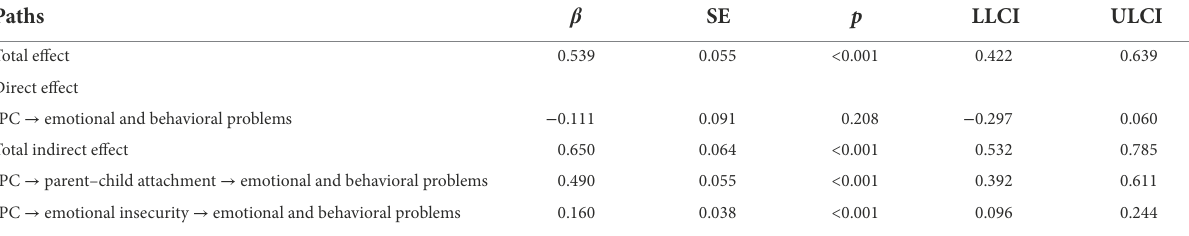
TABLE 2 Standardized direct and indirect paths between IPC and child’s emotional and behavioral problems. Paths